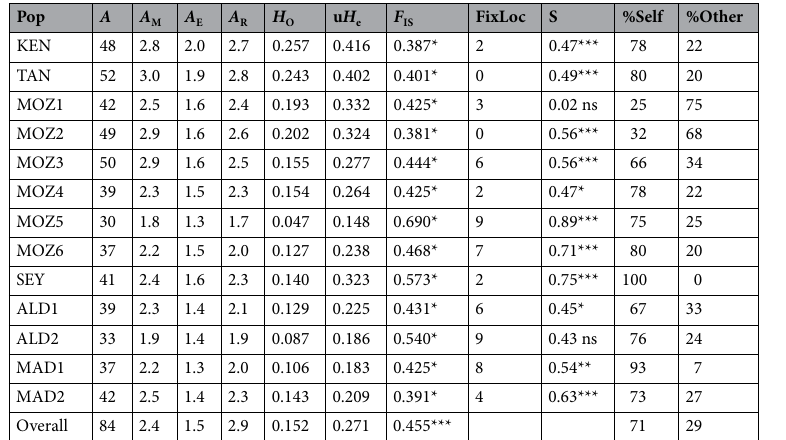
obtained when grouping East Africa (KEN, TAN), versus Aldabra and Madagascar, versus all other populations (MOZ1-MOZ6, SEY). A hierarchical AMOVA considering four regions (Table 3), namely East Africa (KEN and TAN), the Mozambique Channel (MOZ1 to MOZ6), the Seychelles (SEY), and as a fourth group the Aldabra Atoll and Madagascar, gave the largest variance—among all possible groupings—of WIO populations with F RT = 0.185 (p < 0.001). Overall connectivity between populations is very low with an estimated N m less than 1. Pairwise F ST values between populations varied between 0.002 and 0.529 (for which all values except one case were significant at p < 0.001, Supplementary Table S1). Pairwise allelic differentiation D est was congruent with F ST (Supplementary Table S1). Strongest differentiation was obtained for Aldabra (ALD1, ALD2) or Madagascar (MAD1, MAD2) against all other sites. Neighbouring sites appear most connected having lowest F ST and D est (MOZ1 vs. MOZ2; and ALD1 vs. ALD2). A Mantel test for all 13 populations suggested isolation by distance (y = 0.2494x − 0.3533, p = 0.001), but with a low predictability for Euclidean distances (r 2 = 0.24). A more precise test of IBD was performed at the level of individual pairwise kinship coefficients using four classes of increas-